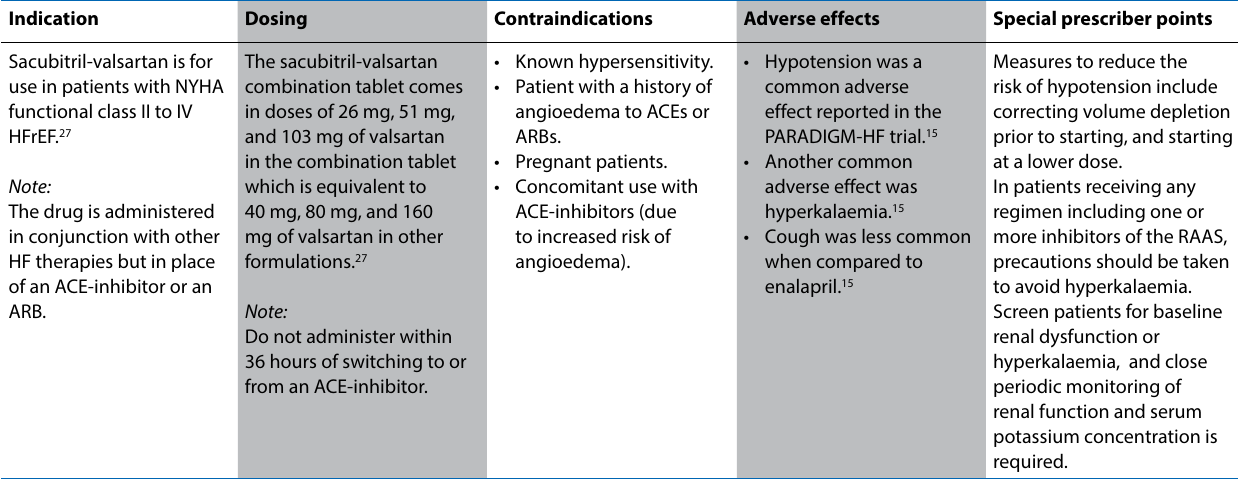
Table Il: Important clinical pharmacology data of the combination of sacubitril-valsartan Indication Dosing Contraindications Adverse